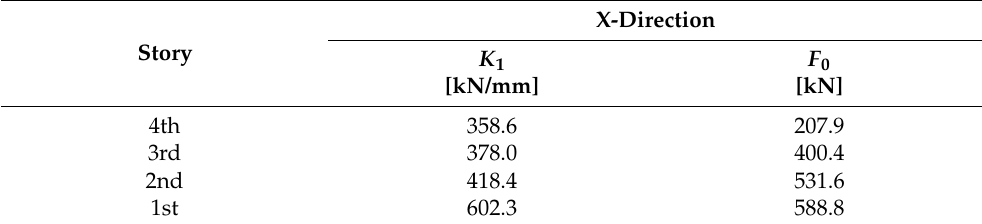
Table 5. Elastic stiffness K 1 and yield force F 0 of the PS-LED dampers installed at each story of the steel